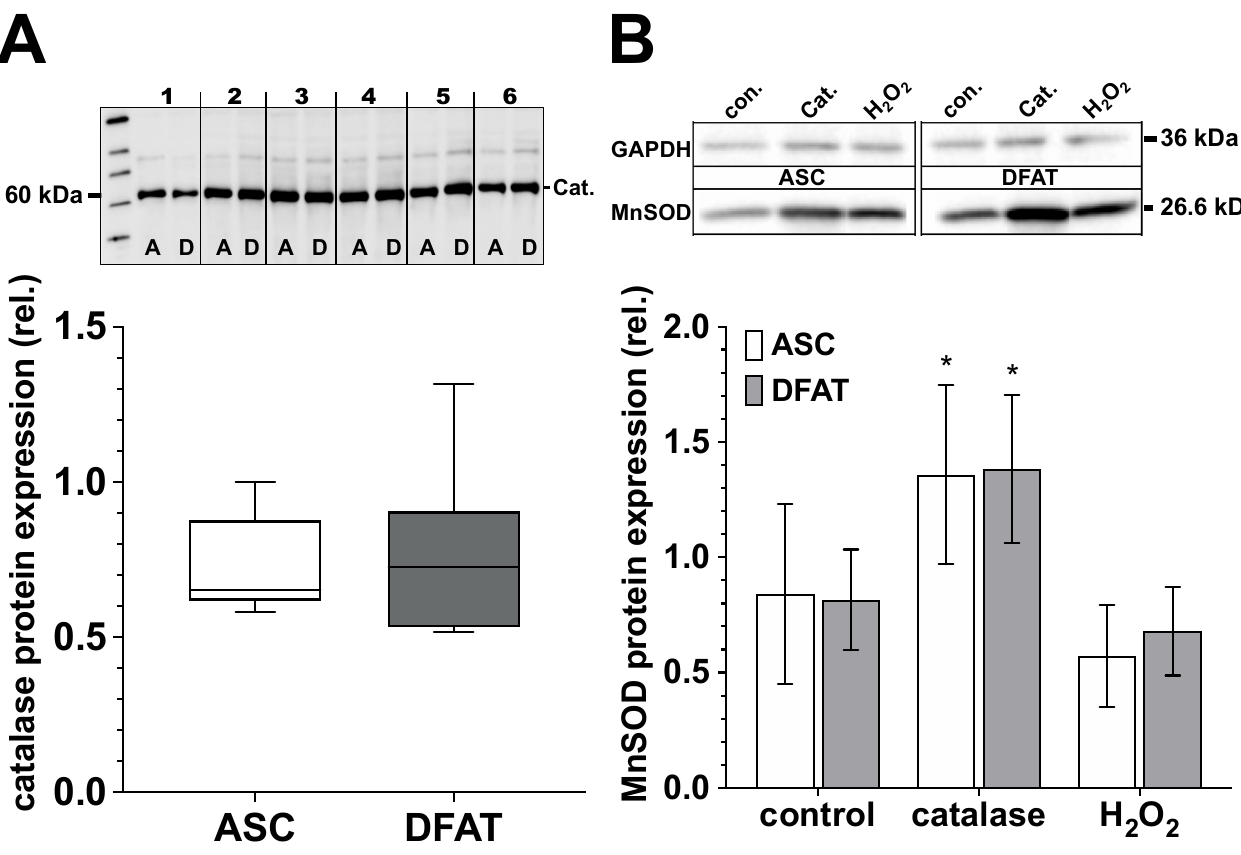
Figure 6. Catalase and MnSOD protein expression of ASC and DFAT cultures obtained from the same adipose tissue. ( A ) Relative catalase protein expression in ASC (white box) and DFAT cultures (gray box) of the same adipose tissue origin. Values are shown as boxplot with median value and with whiskers with minimum and maximum. The specific signal of the catalase expression was normalized to the signal of the protein content of the whole corresponding lane. The representative photograph of the blot shows the protein expression of catalase in ASC ( A ) and DFAT cultures ( B ), which were established from six individual adipose tissue samples. ( B ) Quantification of MnSOD protein expression in control, catalase-treated (250 U/mL) and H 2 O 2 -treated (100 µM) ASC (white bars) and DFAT cultures (gray bars) of the same origin of adipose tissue. The bars show the mean ± SD of four individual experiments. *, p < 0.05 as compared to the controls. The specific MnSOD signals were normalized in comparison to the corresponding GAPDH in the individual sample. The representative photograph of the blot shows the protein expression of MnSOD and GAPDH in ASC ( A ) and DFAT cultures ( B ) after the cultures have been treated accordingly.